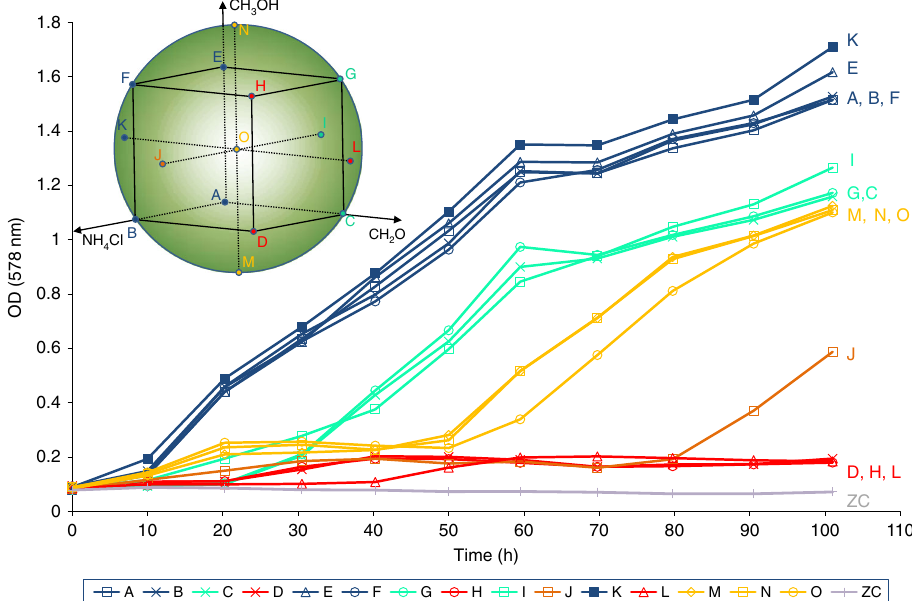
Fig. 2 Schematic of the experimental setting and DoE raw data growth curves showing OD measurements. The DoE is based on a central composite design ( fi gure in the upper left corner). NH 4 Cl, CH 2 O, and CH 3 OH were used as factors during the experiment and systematically varied in a multivariate design space (see Supplementary Table 1 for the concrete values). Each of the factors setting was examined in triplicates. The centre point (O) was examined in quintuplicates. The colours of the dots and the letters of the fi gure in the upper left corner correspond to the growth curves. The line labelled ZC represents the optical density of a corresponding zero control experiment, which was done with the same medium as the experiments labelled with O (central point), but without inoculum. The different colours represent different performances. For better readability, the error bars in this diagram were excluded, which were in a standard deviation range between 0.0009 and 0.1544. According to statistical selection criteria three experiments (one experiment F and two experiments O) were excluded from ANOVA analysis (Supplementary Table 2)